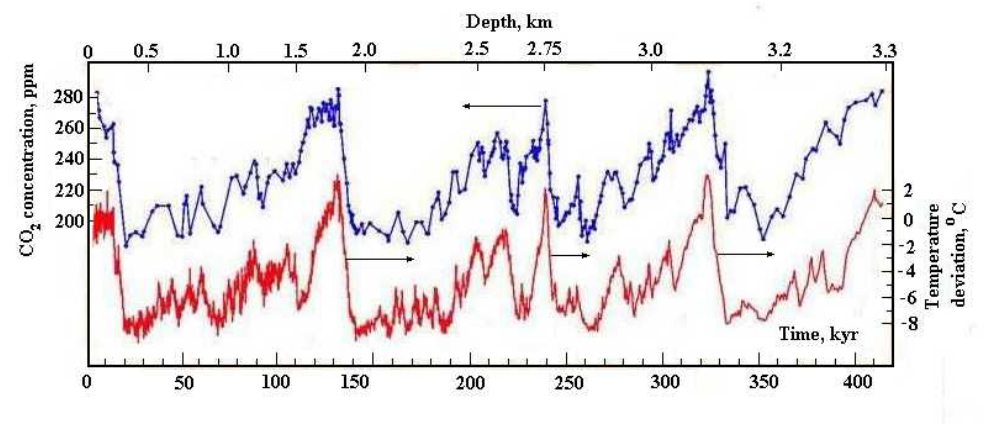
Figure 2. Evolution of the atmospheric carbon dioxide concentration and Earth’s surface temperature in past near Antarctica, obtained by analyzing ice deposits in Antarctica near the weather station Dome C